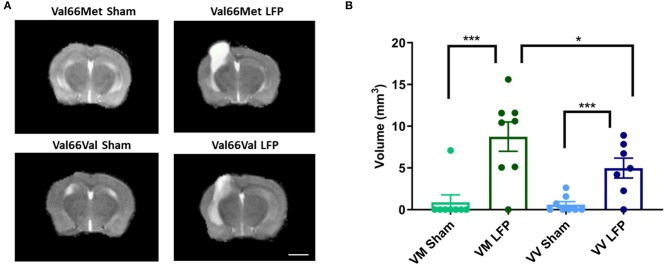
Val66Met injured mice have greater volume of inflammation than Val66Val injured mice. (A) Representative MRI images of mice subjected to LFP and sham at 21 days after the final injury. (B) Quantification of volume of inflammation in different genotypes, 21 DPI as determined by assessment of hyperintensity ROI. *p < 0.05, ***p < 0.001, ANOVA Fisher's PLSD post-hoc test relative to indicated groups, n =7–8. Scale bar = 3 mm.